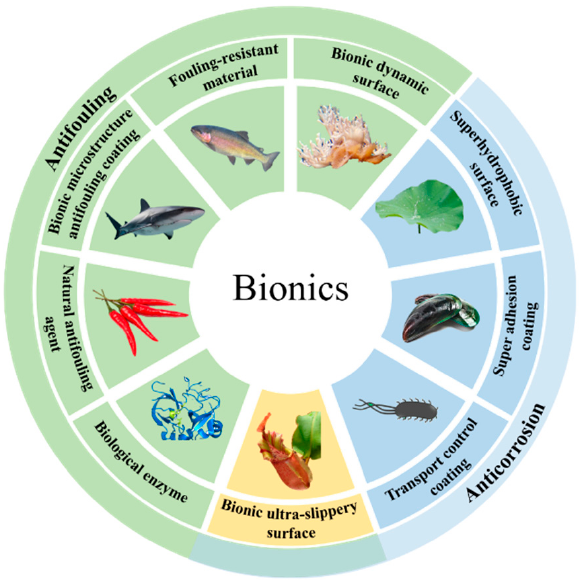
Figure 1. Bionic antifouling and anticorrosion strategies.